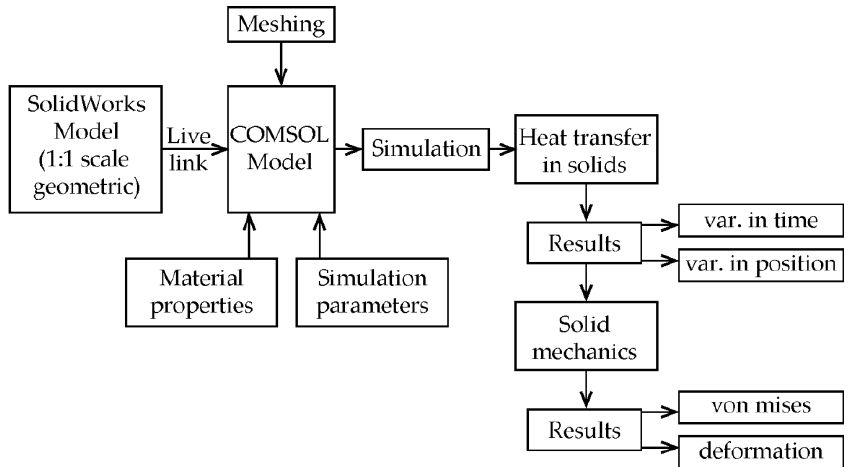
Figure 3. Workflow of the computer simulation.